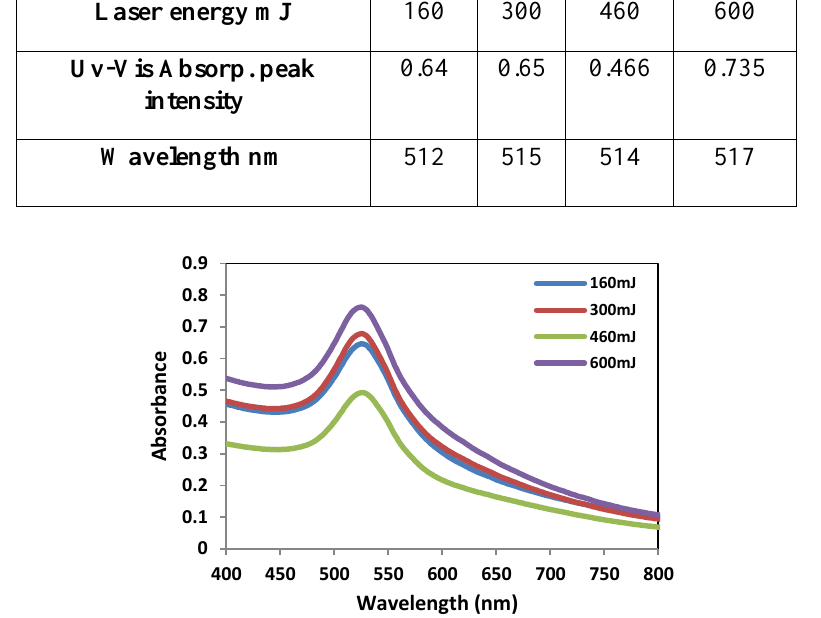
Table 1: Effect of different laser energy on Uv-Vis peak and wavelength.